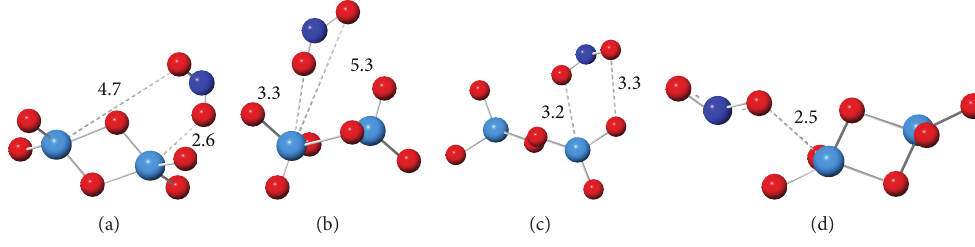
@ Table 4: Calculated quantum chemistry reactivity indices for NO 2